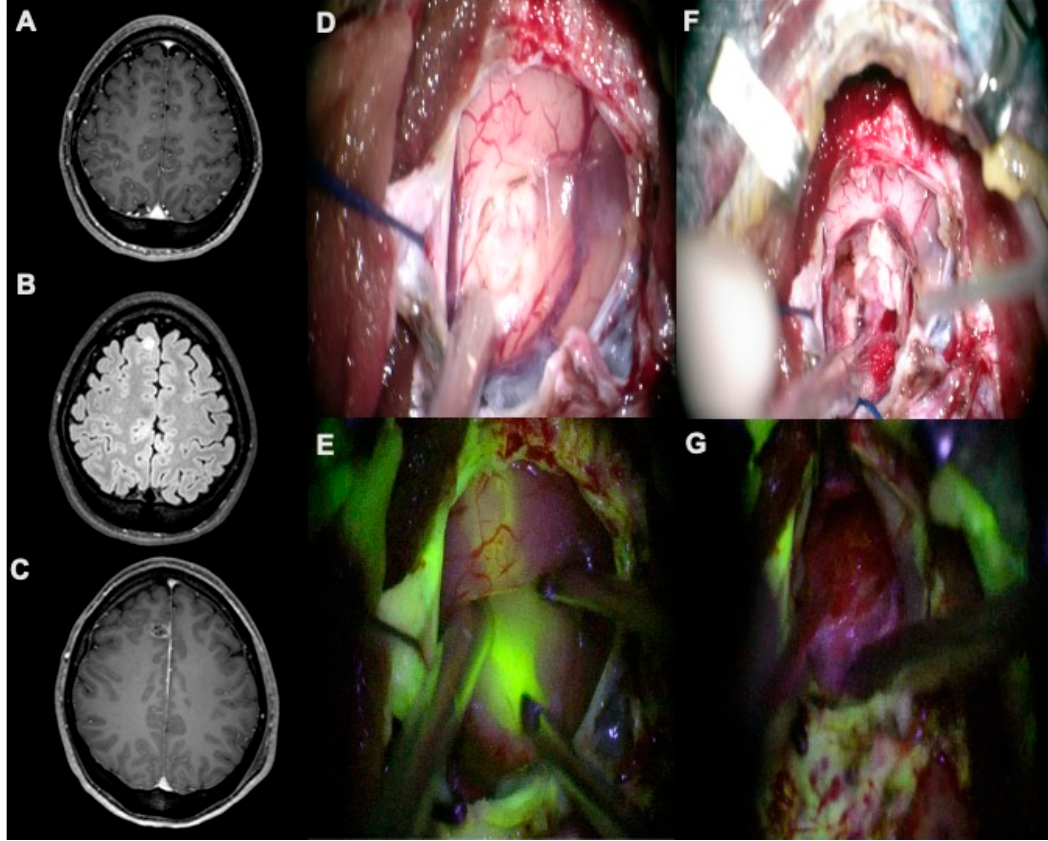
Figure 1. ( A , B ) Preoperative, postcontrast axial T1-weighted and axial FLAIR-weighted scans showing a right frontomesial ganglioglioma, completely removed as detectable by postoperative, postcontrast axial T1-weighted scan ( C ). ( D , E ) During surgical resection, YELLOW 560 filter highlighted pathologic tissue allowing the identification of a clear plane of dissection by using the fluorescent visualization. ( F , G ) At the end of resection, the cavity did not show any sign of a residual tumor, as confirmed by fluorescent visualization with YELLOW 560 filter.